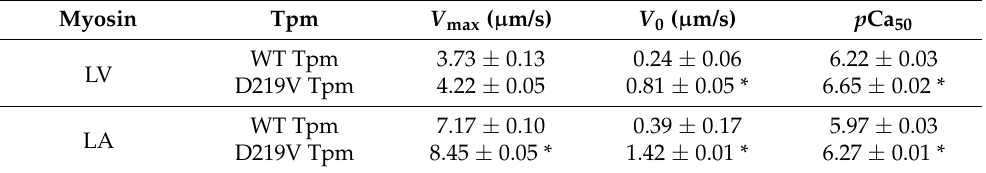
Figure 5. The effects of the D219V Tpm mutation on the Ca 2+ -dependent sliding velocity of regulated thin filaments moving over ventricular ( A ) and atrial ( B ) myosin in the in vitro motility assay. Each data point represents the mean ± SD from three experiments. The data are fitted with the Hill equation, and the parameters of the p Ca-velocity relationships are presented in Table 3. Table 3. The parameters of the p Ca-velocity relationship of the thin filament containing WT or D219V Tpm in the in vitro motility